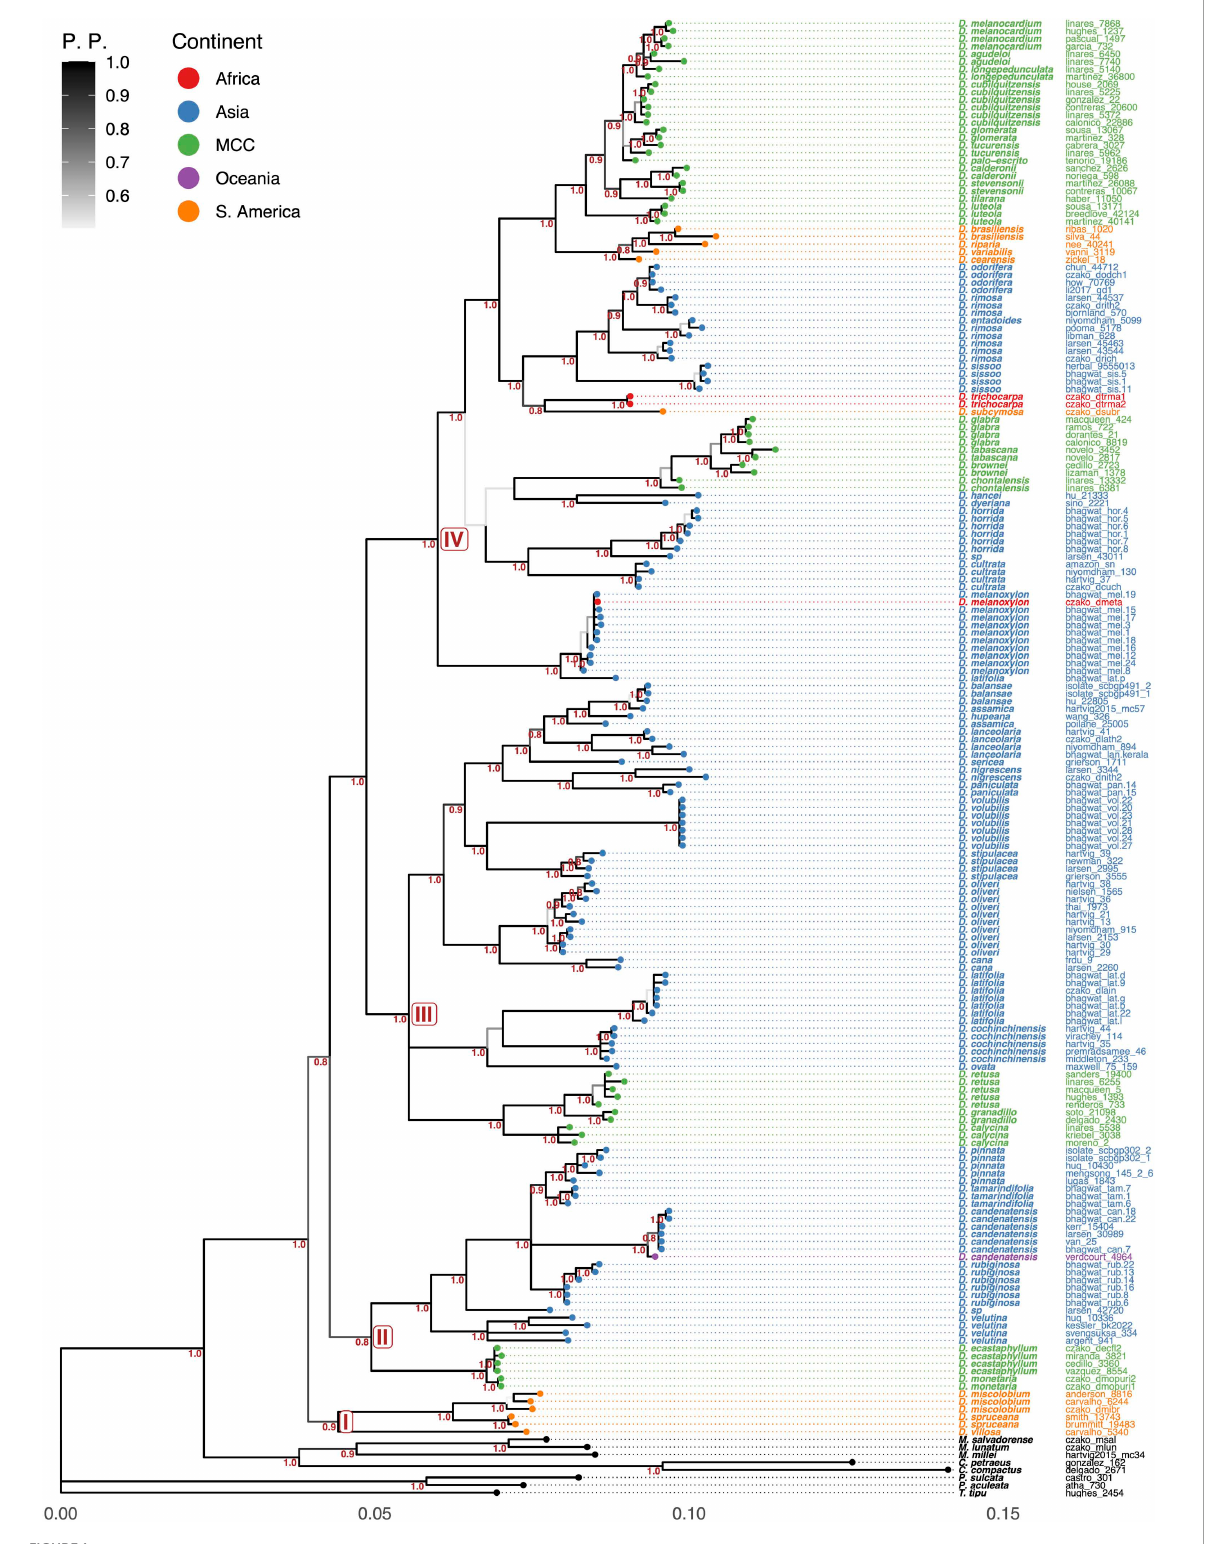
FIGURE1 Bayesian combined phylogram of Dalbergia . Under the branches, posterior probabilities (pp) are in red font.